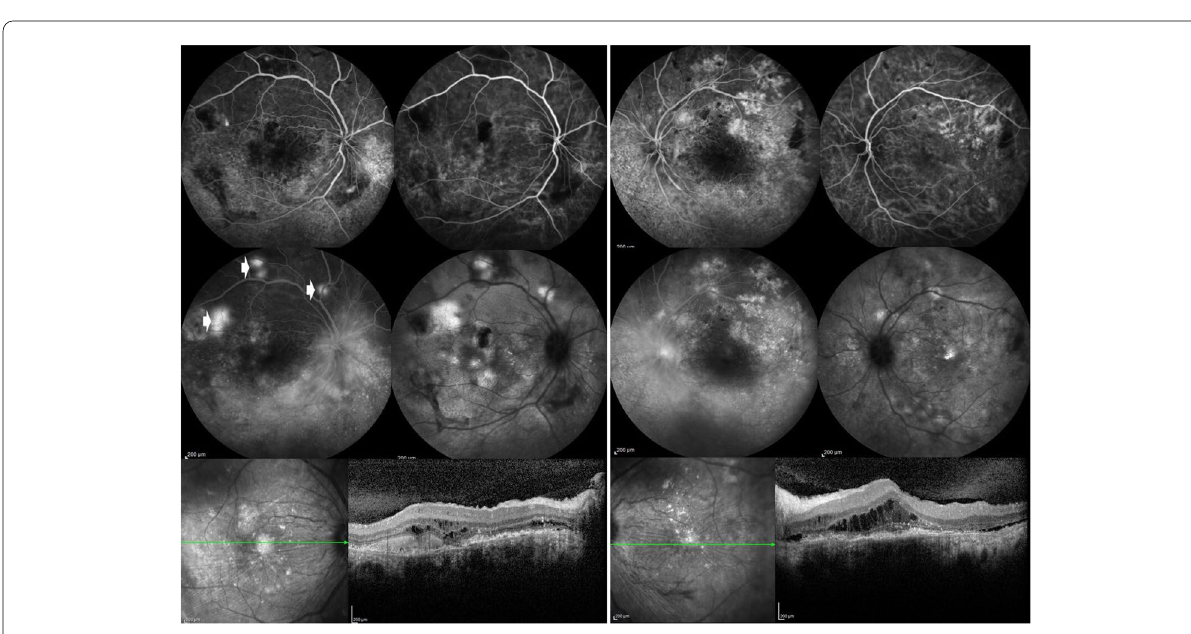
Fig. 5 Dual fluorescein‑indocyanine green angiography and optical coherence tomography imaging of a 36 year‑old woman with systemic lupus erythematosus unresponsive to aggressive immunomodulatory treatment. Early phase fluorescein angiography (FA) shows extensive retinal pigment epithelial changes with window defects in the right ( top row, first frame ) and the left eye ( top row, third frame ); and late phase FA shows hyperfluorescence of the optic disc and peripapillary vasculature as well as subretinal staining/pooling (arrows) in the right eye ( middle row, first frame ) and staining of the optic disc and vessel walls in the left eye ( middle row, third frame ). Early phase indocyanine green angiography (ICGA) shows dilated and hyperfluorescent choroidal vessels in both the right ( top row, second frame ) and the left eye ( top row, fourth frame ); and late phase ICGA shows more numerous and larger hyperfluorescent areas than revealed by FA in the right eye ( middle row, second frame ) and also scattered hyperfluorescent spots in the left eye ( middle row, fourth frame ). SD‑OCT shows extensive damage to the outer retina with chronic cystoid changes, subretinal hyperreflective material, and retinal pigment epithelium loss and irregularities in both the right ( bottom row, left ) and the left eye ( bottom row, right